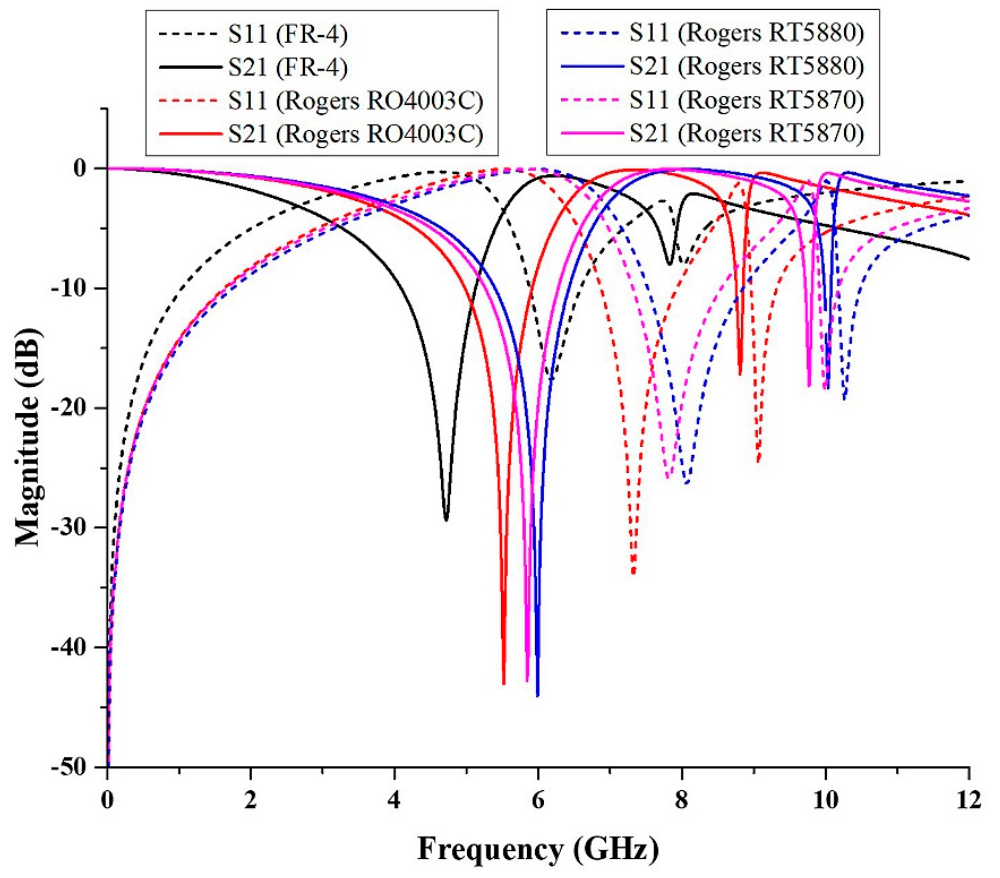
Figure 10. The comparison of S 11 and S 21 for the different type of substrate Table 3. Comparison of the S-parameters result for metamaterial structure using different sub- strates.